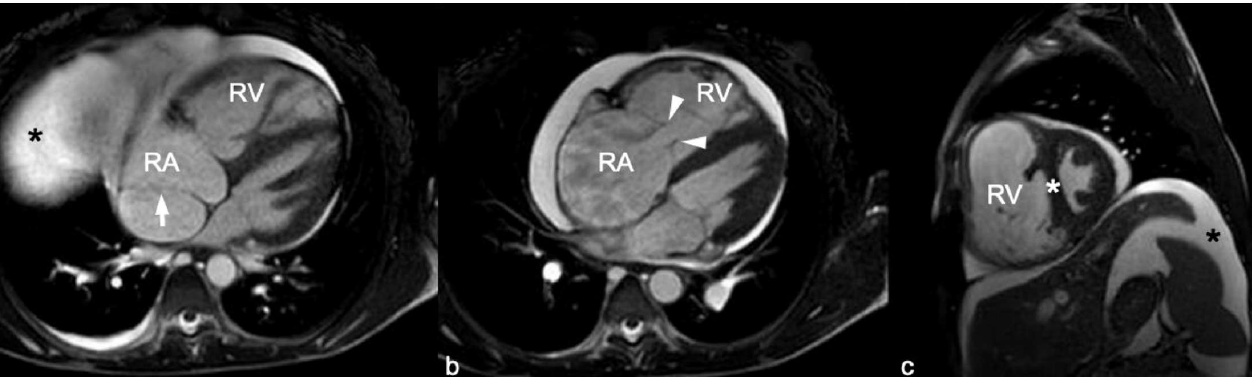
Figure 3. SSFP Cardiac MR images in the 4 chamber ( a , b ) and short axis ( c ) planes. RV and RA are